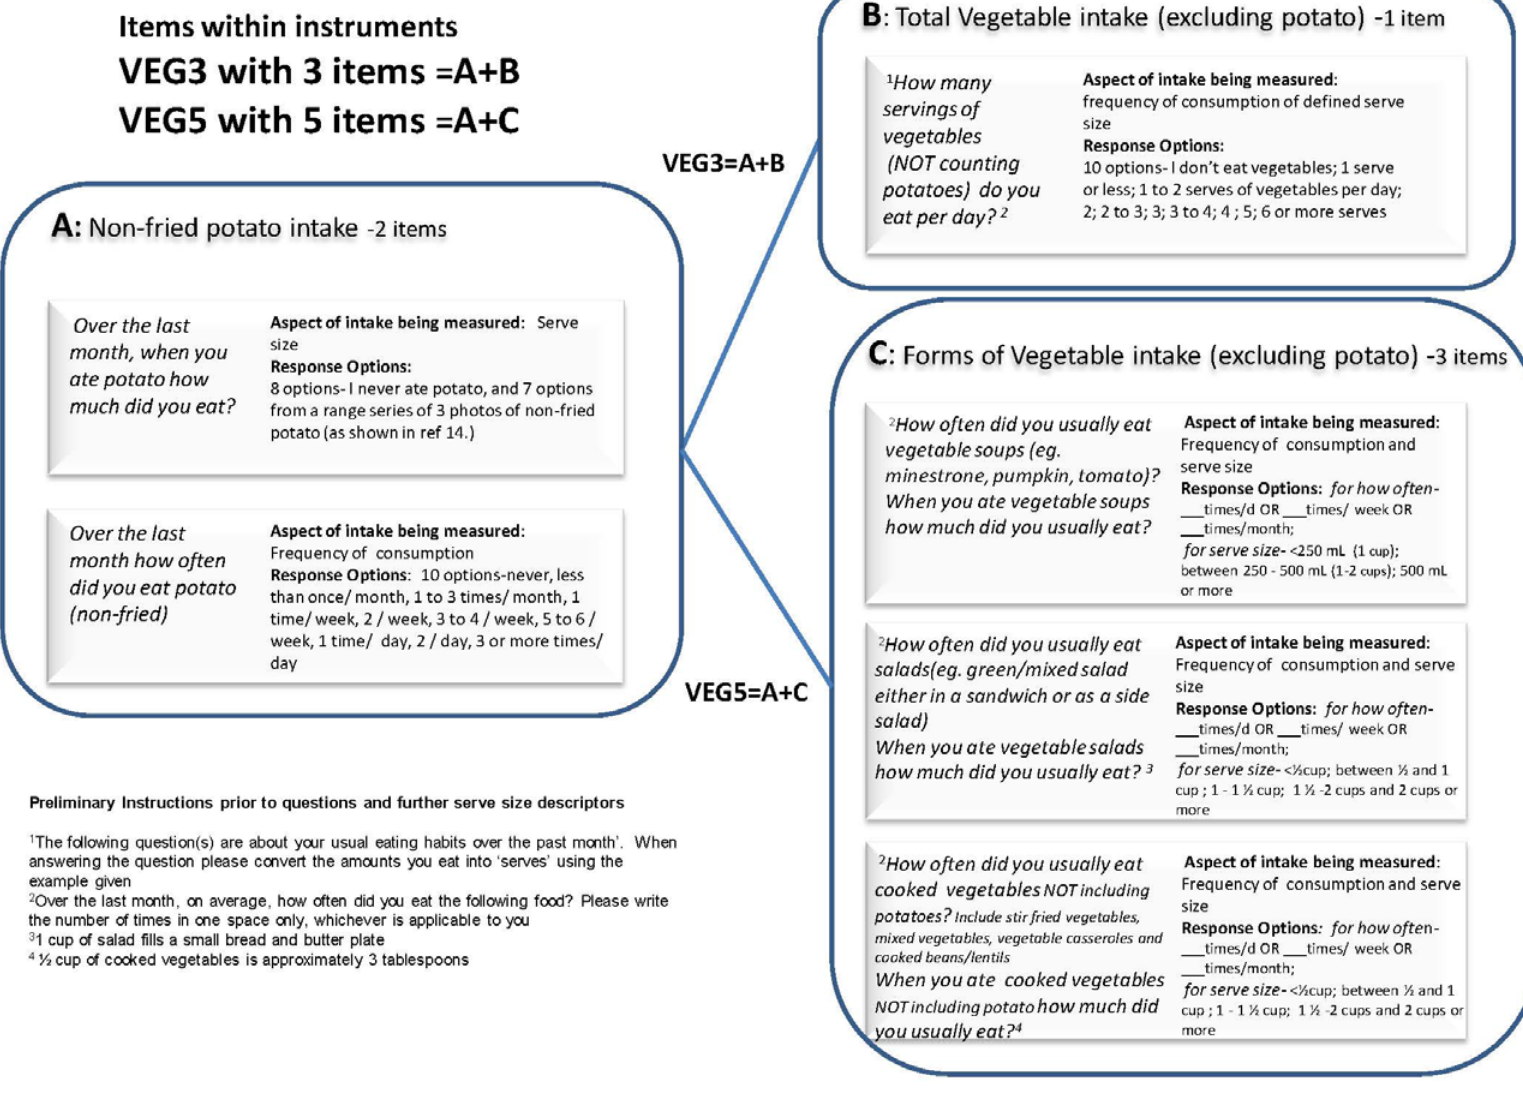
Figure 1. Vegetable consumption question details for VEG3 and VEG5.